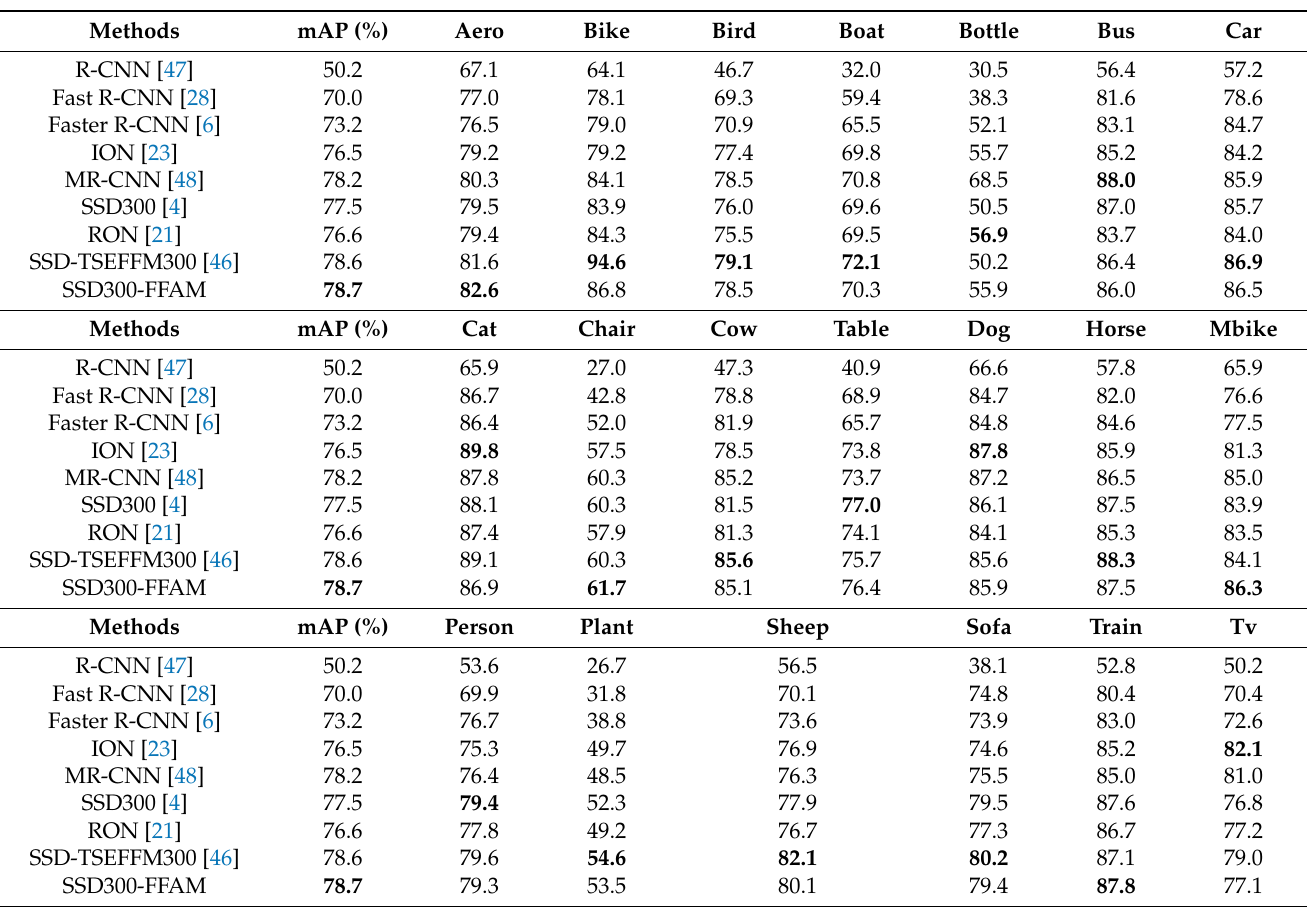
Table 4. Detection results of the proposed SSD300-FFAM and state-of-the-art detectors on the Pascal VOC 2007 test set. All models were trained with 07+12 (VOC 2007 trainval + VOC 2012 trainval). The entries with the best APs for each object category are